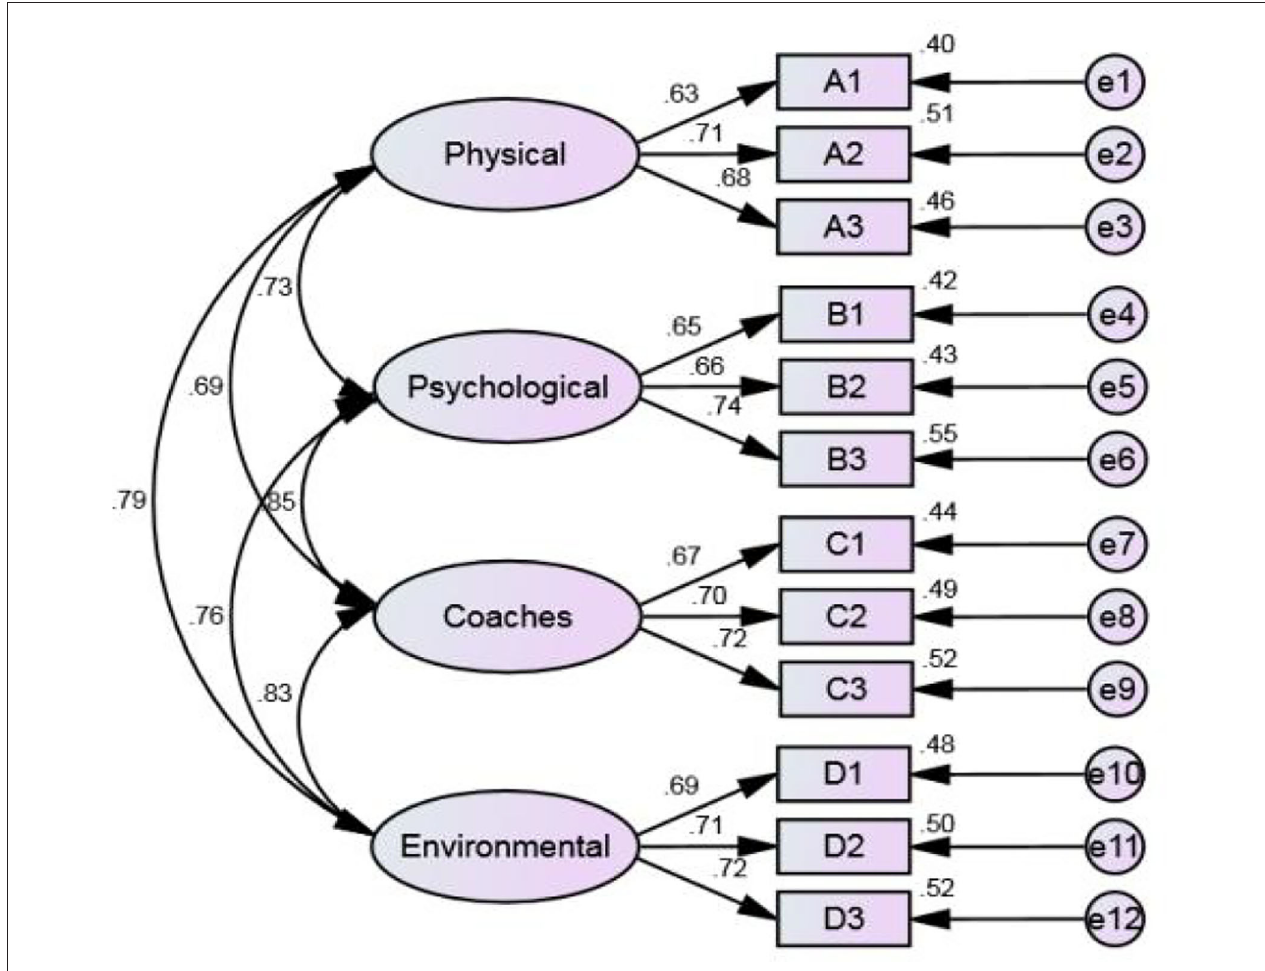
FIGURE 5 | Standardized estimates.